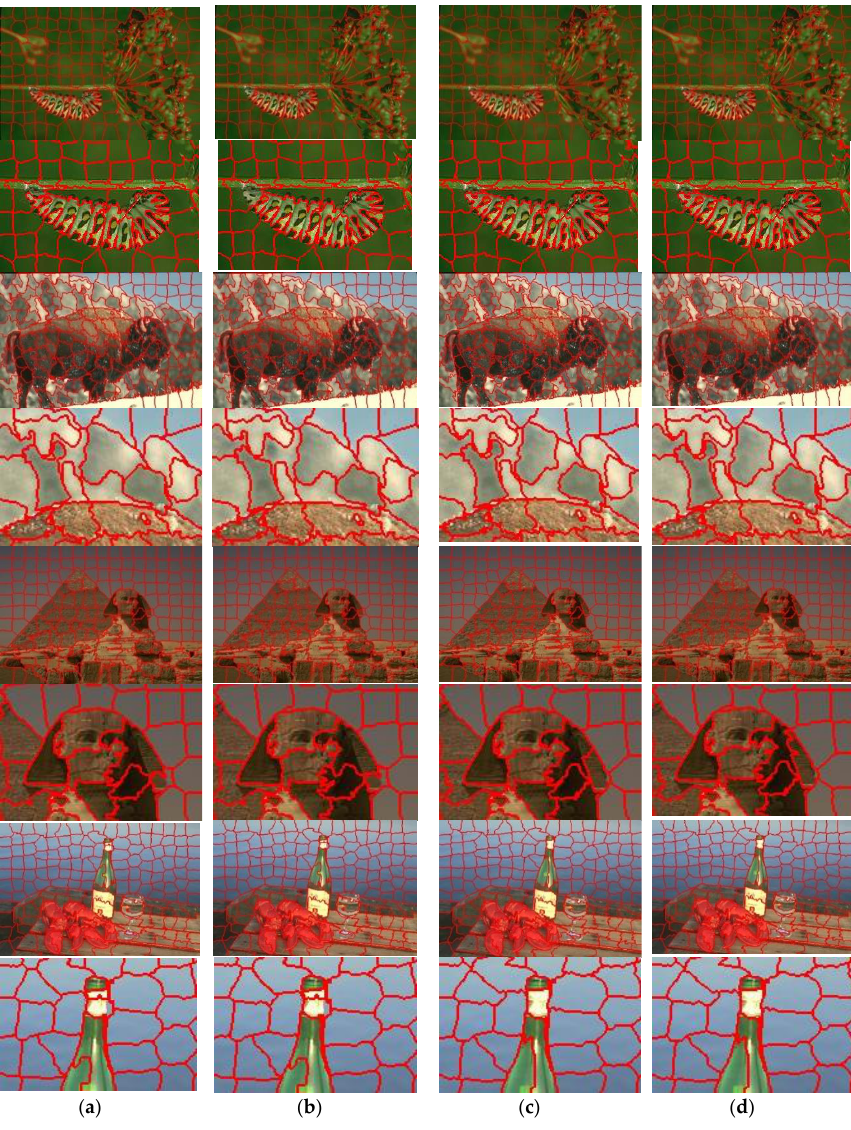
Figure 7. Visual comparison of superpixels with K = 200 on BSDS500. ( a ) SNIC; ( b ) Accelerated Implementation based on Recursion (AIR)-based Non-Iterative Clustering (ANIC); ( c ) EIR-based Non-Iterative Clustering (ENIC); ( d ) non-iterative clustering with efficiency (NICE). Alternating rows show each segmented image followed by local details of each image.